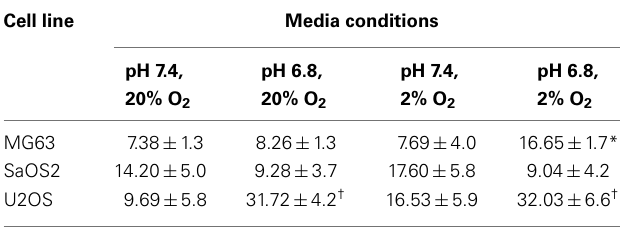
Table 1 |The invasion index of three osteosarcoma cell